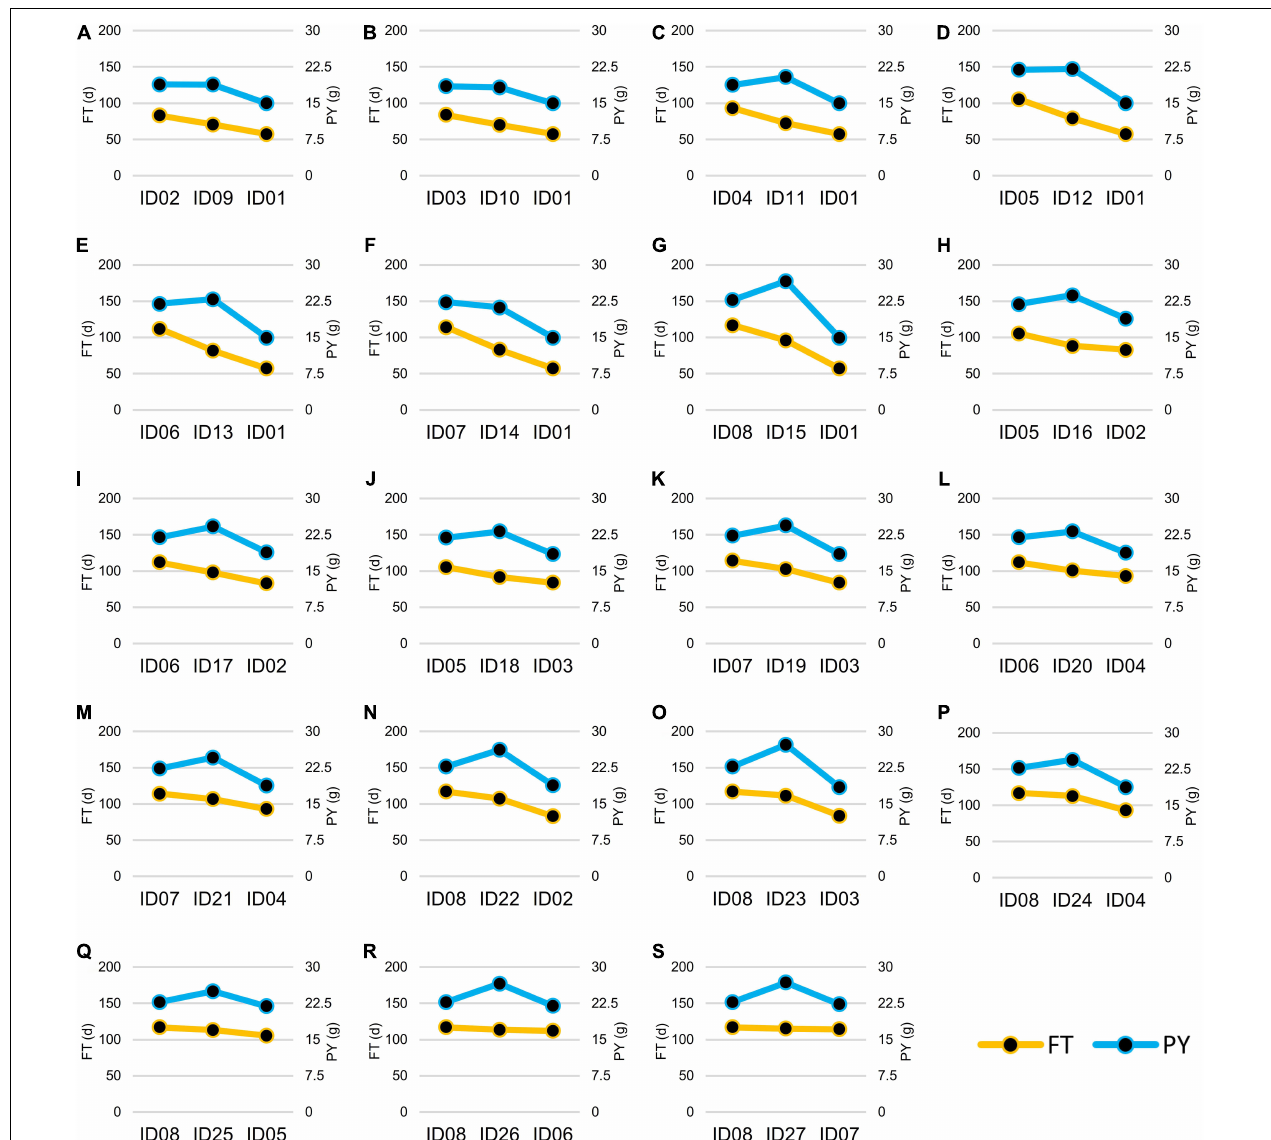
FIGURE 6 | Flowering time (FT) and plant yield (PY) of the 19 NIL hybrids and their crossing parents. For each of the box from (A–S) , the left side was the female parent, the right side was the male parent, and the middle was the hybrid. The left vertical axis and the yellow line showed FT (d), while the right vertical axis and the blue line showed PY